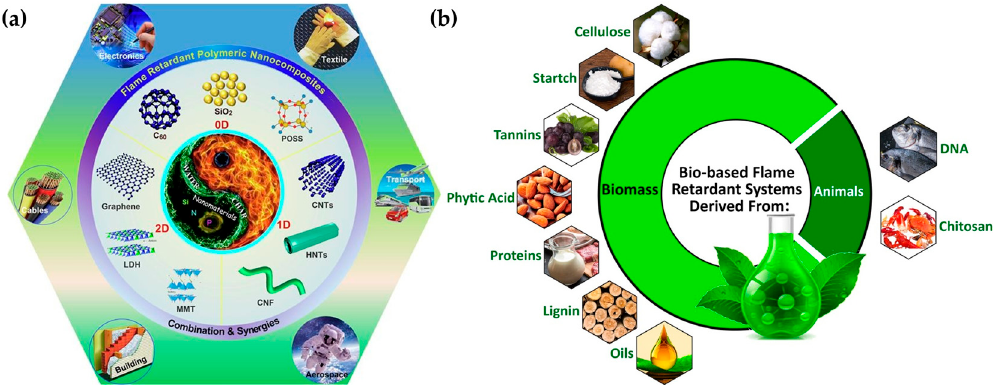
Figure 8. Different agents employed for the preparation of flame-retardant polymeric composites from nanomaterials ( a ) to bio-based derivatives ( b ). Reprinted with permission from Ref. [102];